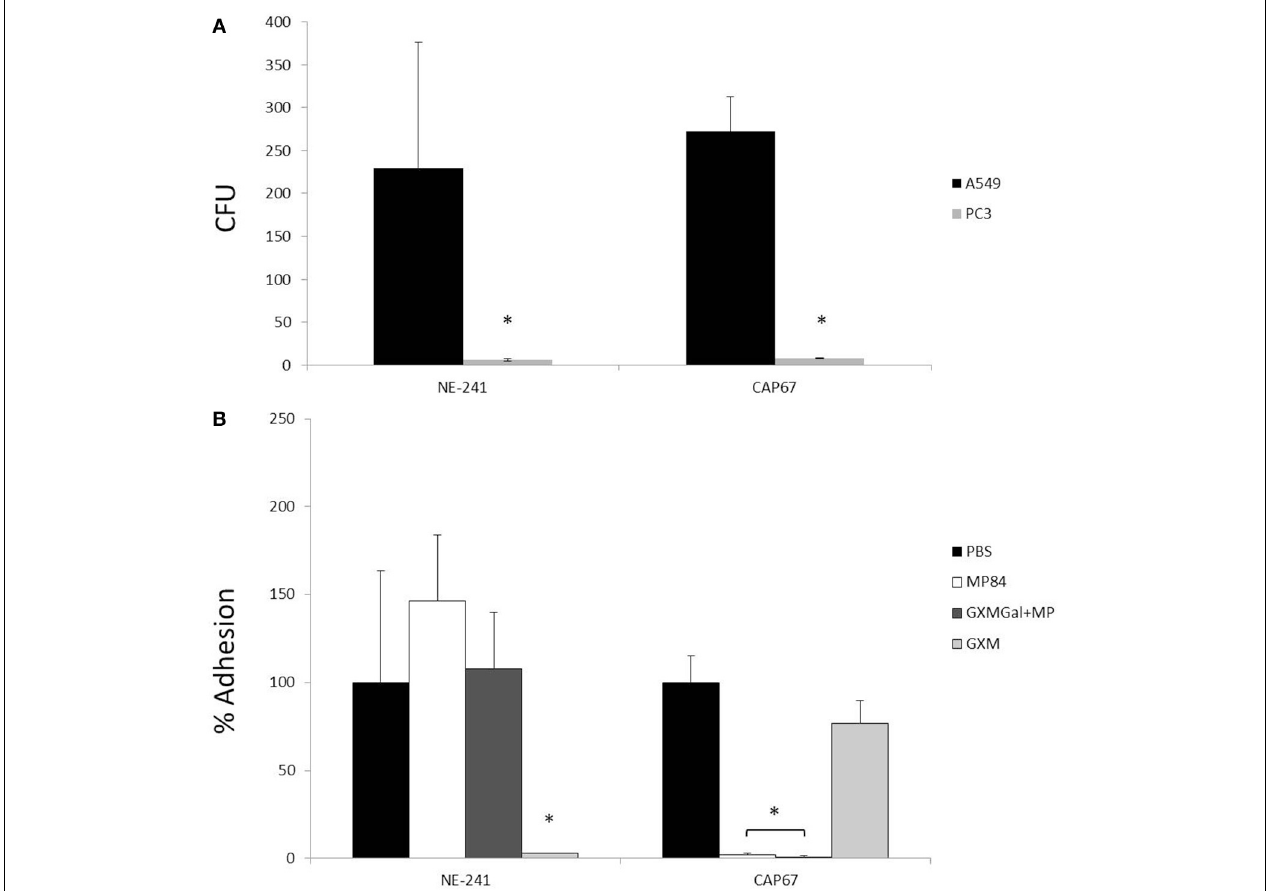
FIGURE 4 | Interaction of C. neoformans with epithelial lung cells. Capsulated (NE-241) and non-capsulated (CAP67) C. neoformans strains were interacted with prostate human epithelial cells (PC3) or with epithelial lung cells (A549), with or without the presence of capsule constituents (GXM, GXMGal + MP or MP84). The interaction of C. neoformans with host cells was determined after counting colony forming units (CFUs) of viable yeasts recovered after 1h of incubation. (A) CFUs of capsulated (NE-241) and